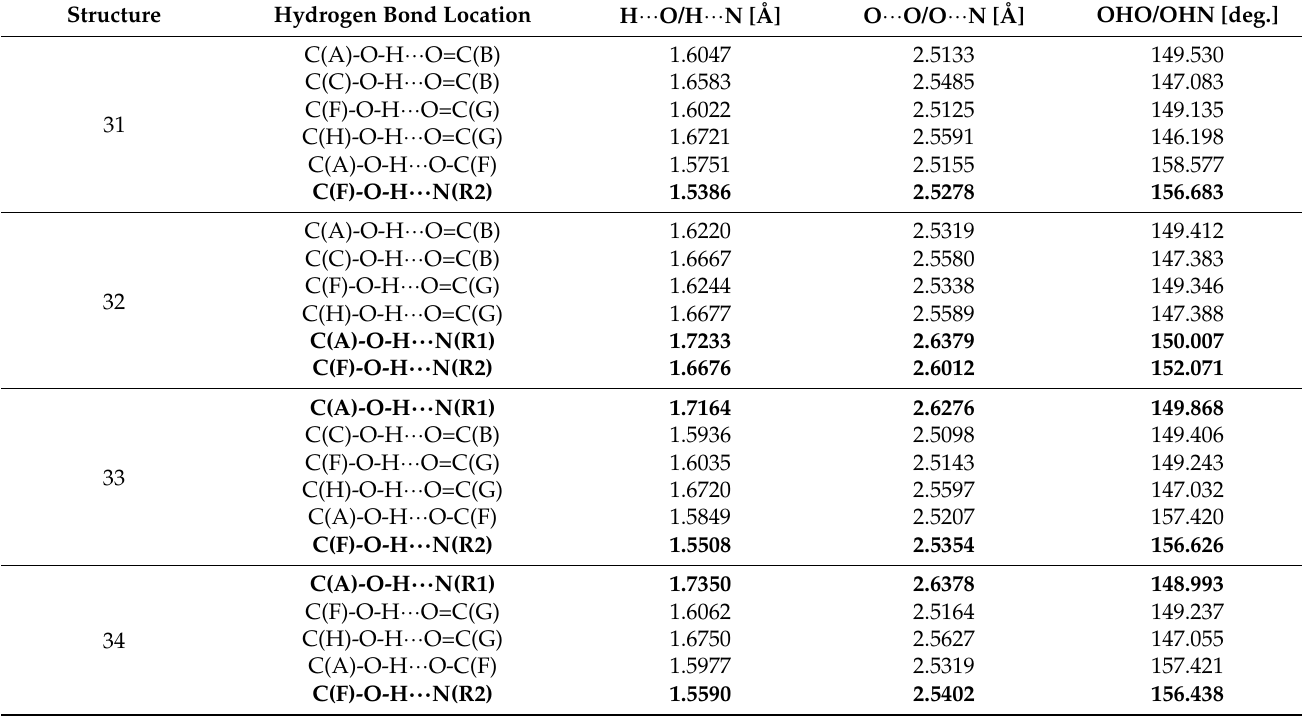
Figure 6. Conformers (31–36) of fagopyrin F. Table 2. Hydrogen bonds in possible fagopyrin F conformers. σ = 0.0001 [Å], σ = 0.001